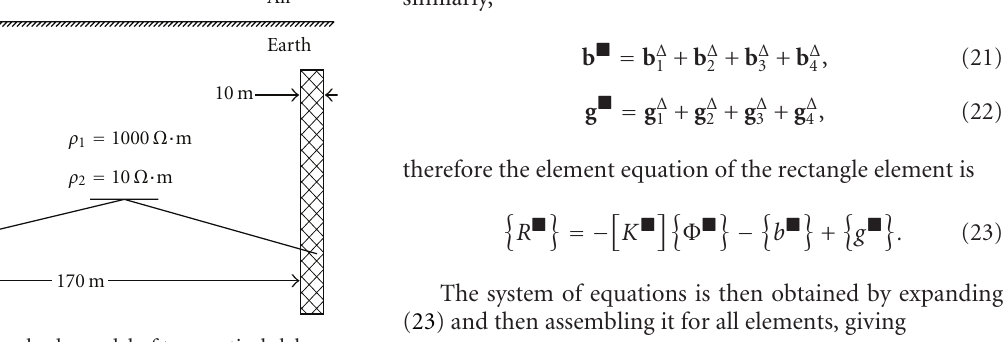
Figure 5: Compound orebody model of two vertical